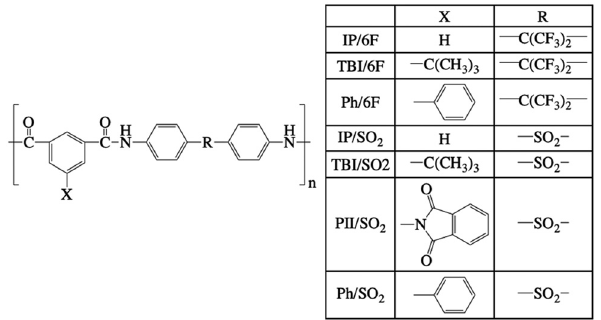
Figure 2: Structure of the polyisophthalamides containing di ff erent bulky pendant groups ( 57,59,60 )